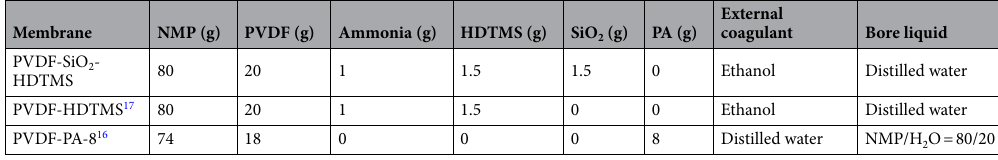
Table 1. Polymer dope composition.